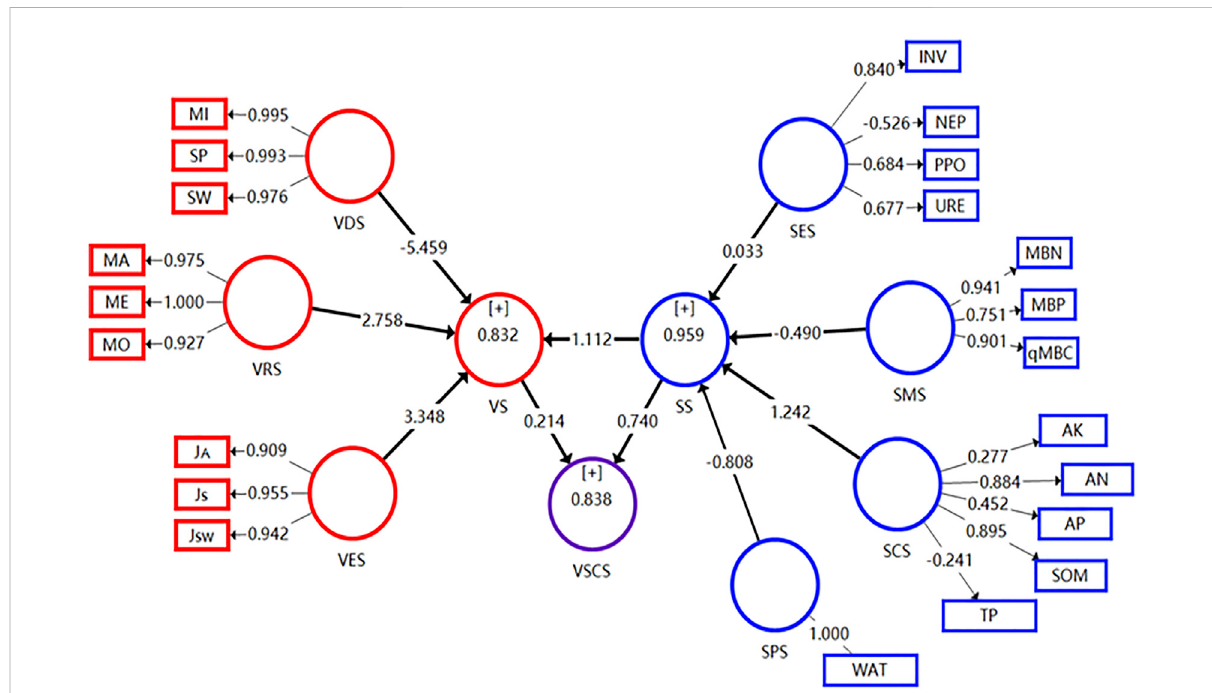
FIGURE 3 PLS-PM analysis map under different vegetation restoration models. Notes: VDS: vegetation diversity subsystem; VRS: vegetation richness subsystem; VES: vegetation uniformity subsystem; VS: total vegetation system; SS: habitat materials total system; SES: habitat materials enzyme subsystem; SMS:habitatmaterialsmicroorganismsubsystem;SCS:habitatmaterialschemistrysubsystem; SPS:habitatmaterialsphysicssubsystem; VSCS: habitat materials and vegetation system coupling coordination